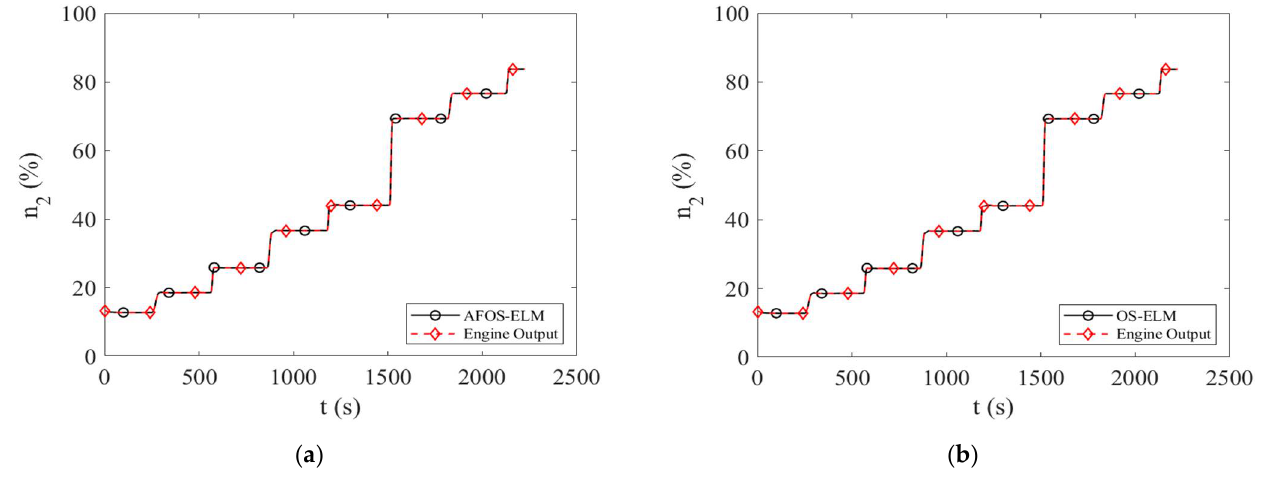
Figure 3. Comparison of neural network n 2 ( k + 1) output. ( a ) AFOS-ELM n 2 ( k + 1) output; ( b ) OS-ELM n 2 ( k + 1) output. Table 2. Relative error of neural network output